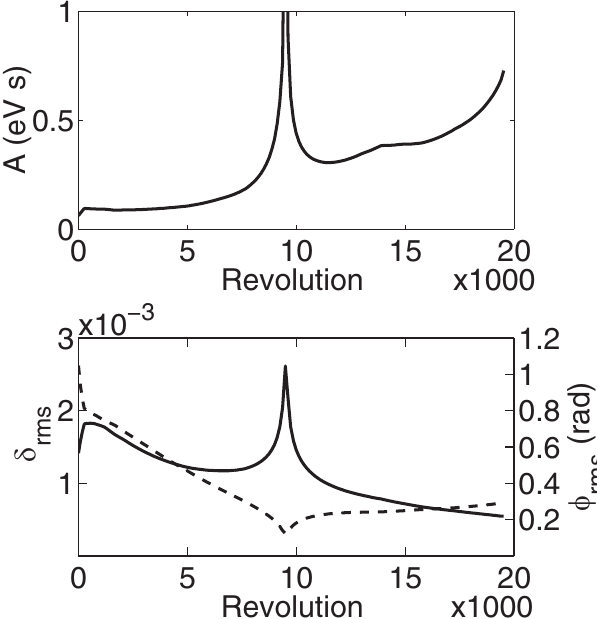
FIG. 15. Top: The bucket area throughout the booster cycle. The bucket area is about 0 : 08 eV - s at the beginning of the (solid) ramping cycle. Bottom: The rms momentum width (cid:2) (cid:5) (dashed), assuming phase-space area and rms bunch length (cid:2) (cid:10)